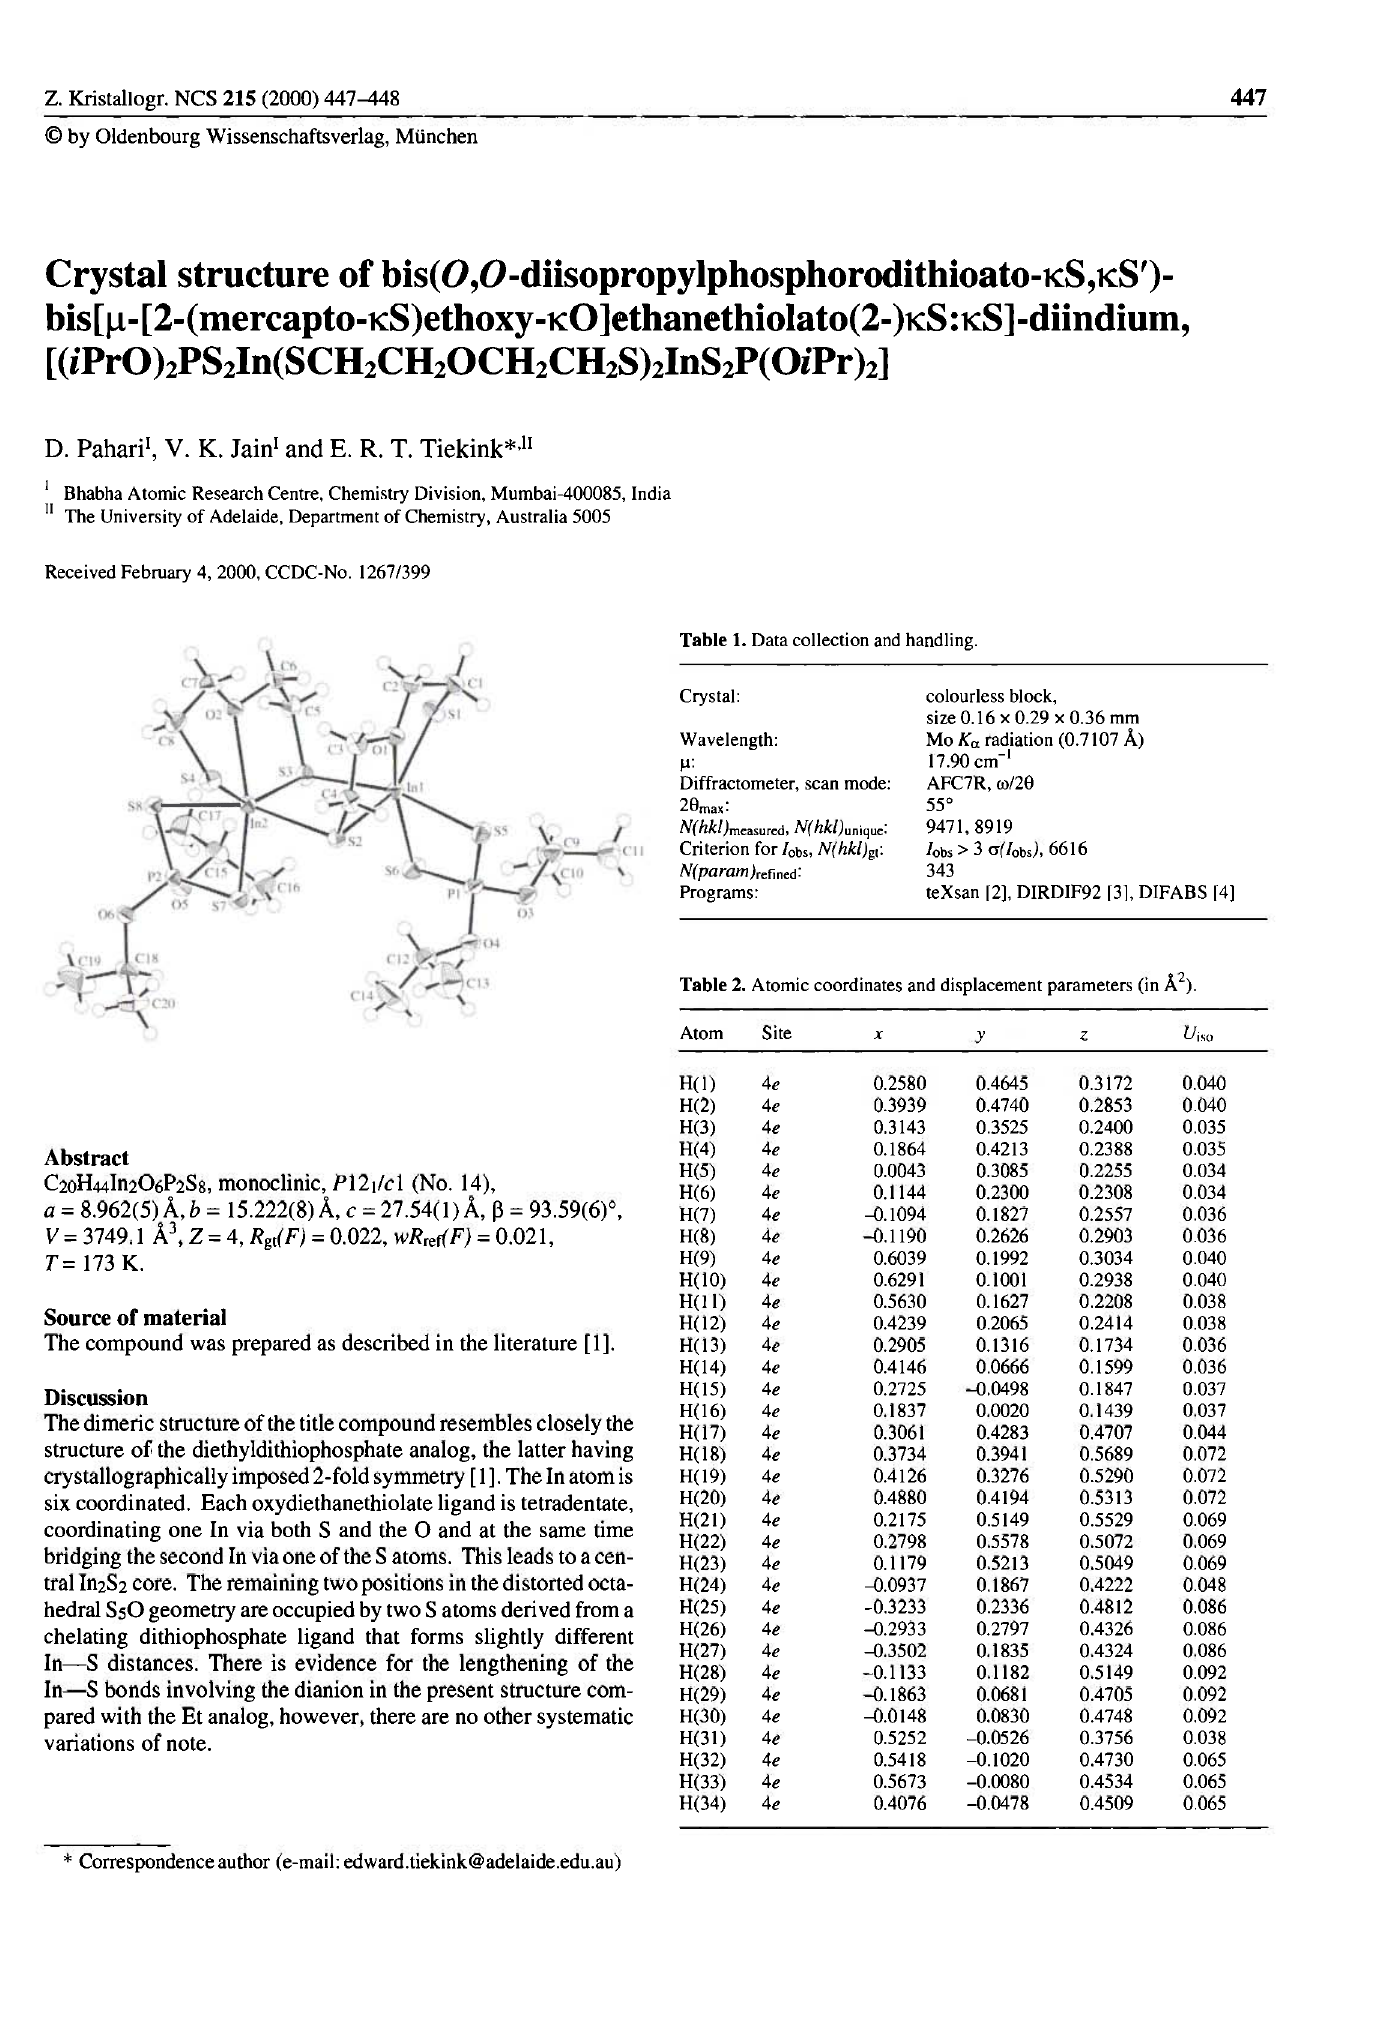
Table 1. Data collection and handling.